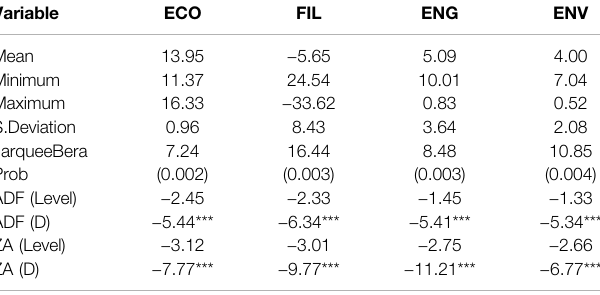
Denotes a 1 percent signi fi cance level.